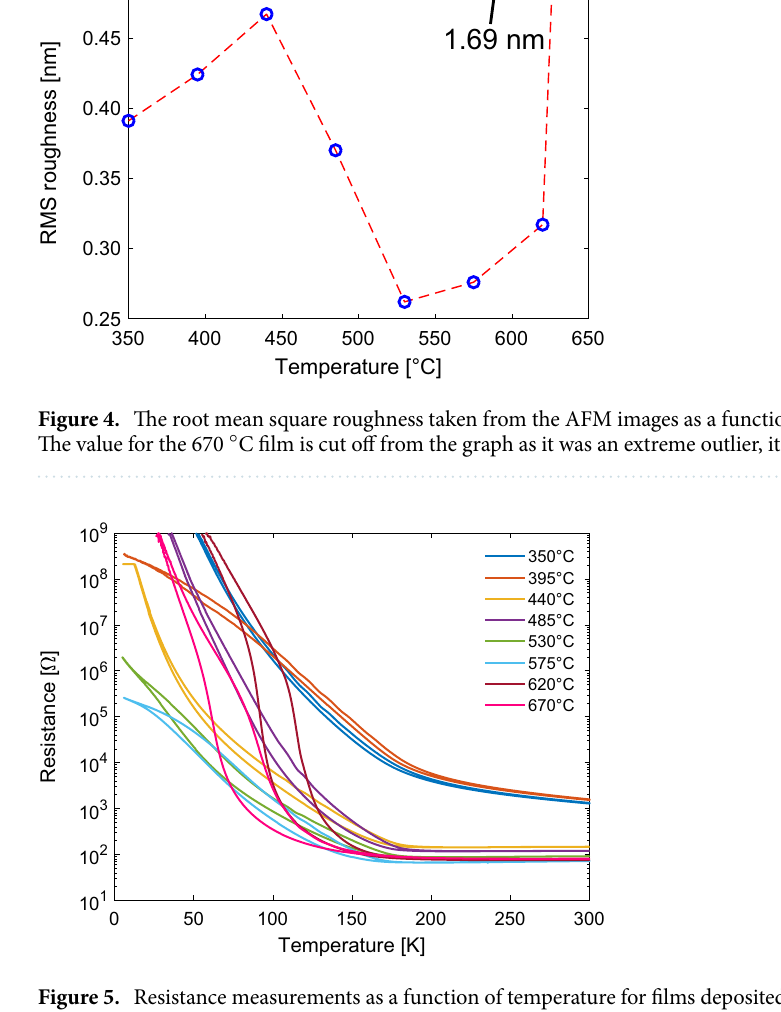
Figure 5. Resistance measurements as a function of temperature for films deposited under different substrate temperatures. The results reveal three distinct classes of resistance curves which can be classified into three types ◦ of films depending on their growth temperature. Type I ( < 400 C) display a high room temperature resistance ◦ with a narrow hysteresis, type II films (grown at 400–600 C) display a lower room temperature resistance and a ◦ stronger hysteresis, and type III ( > 600 C) show a sharper transition with a stronger hysteresis shifted to lower